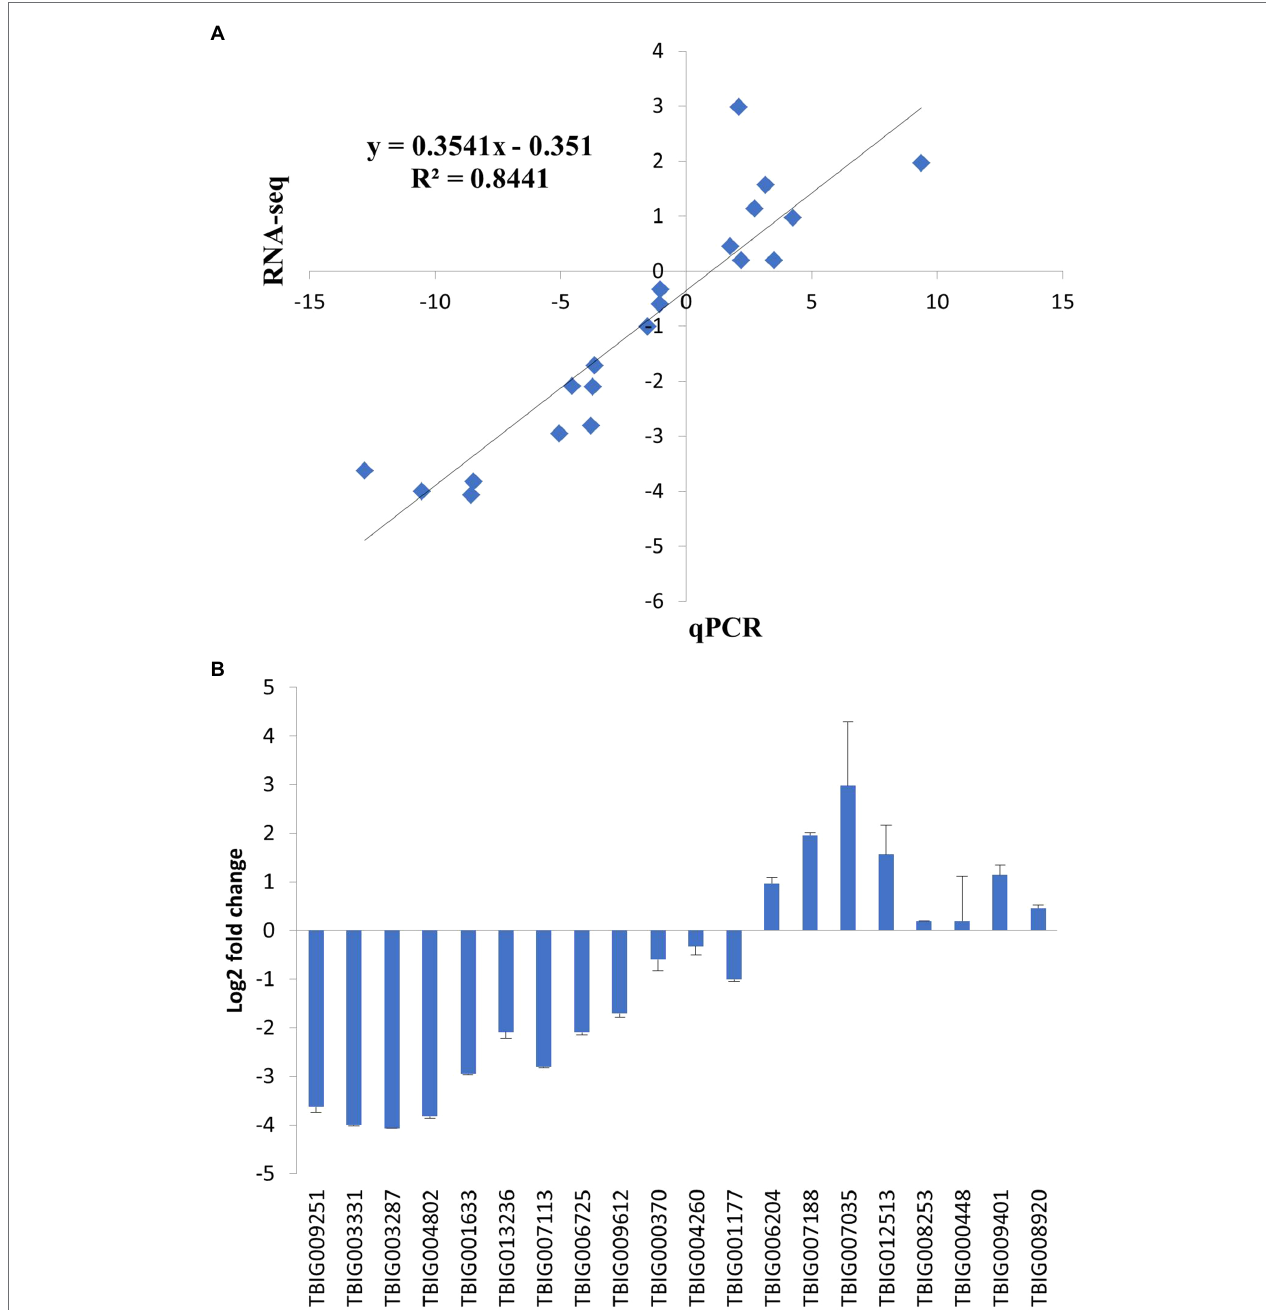
FIGURE 6 | Validation of RNA-seq results using quantitative real-time PCR (qPCR). The relative expression levels of randomly selected genes were analyzed by qPCR to validate RNA-seq results. Each fold change was calculated by qPCR using the 2 − ∆∆ C t method, and the log 2 ratio of the obtained values was compared with the log 2 ratio of RNA-seq results, which were based on normalized in vivo FPKM to FPKM by DEGseq. (A) Correlation of fold change measured between RNA-seq ( x -axis) and qPCR ( y -axis). (B) Log 2 fold change measured by qPCR. Error bars represent standard